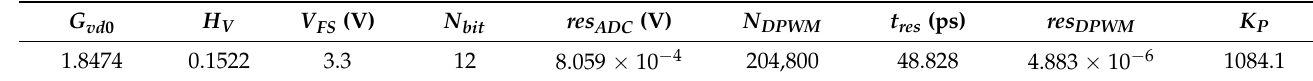
Table 5. Digital control loop parameters used in Equations (38)–(41).